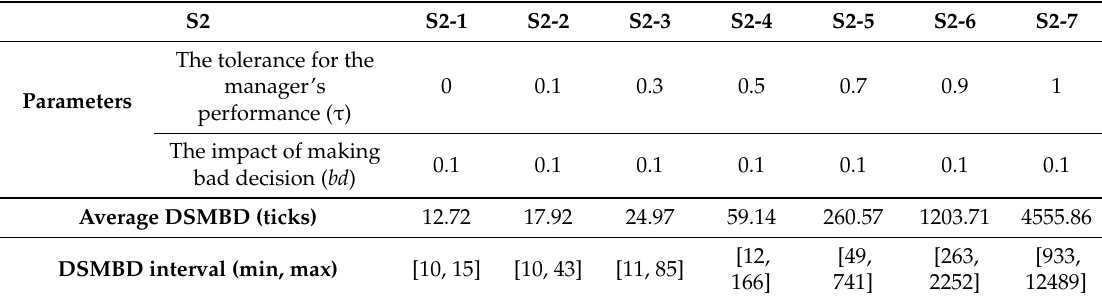
Table 8. Simulation’s results for S2 when bd = 0.1.